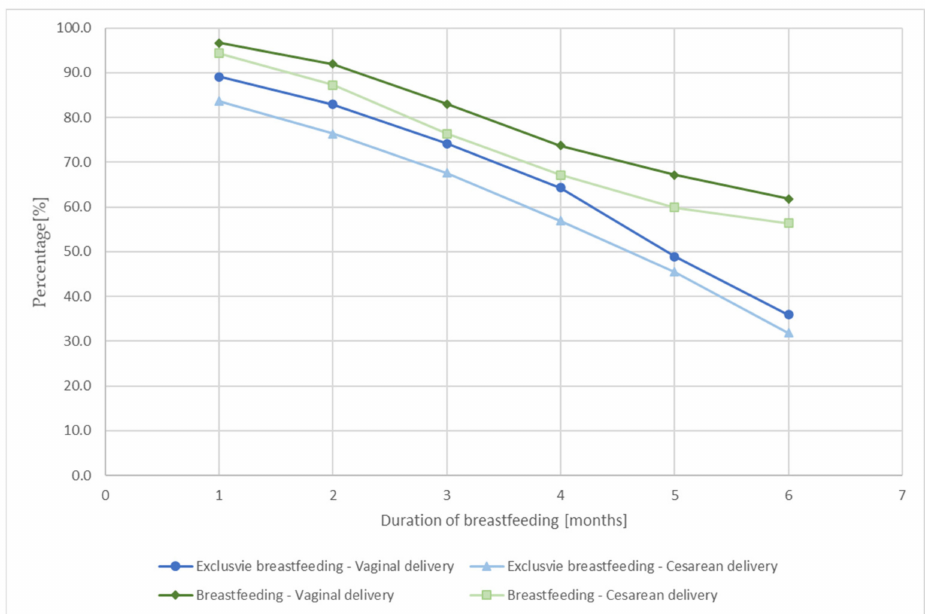
Figure 1. Duration of breastfeeding and exclusive breastfeeding in the case of vaginal delivery and caesarean